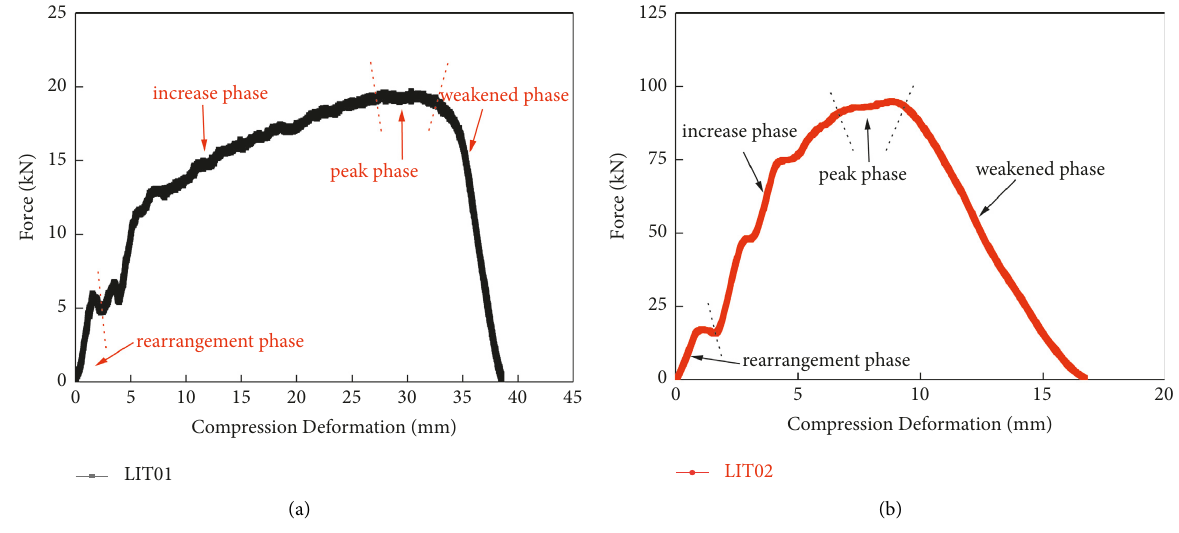
Figure 9: Diagram of impact force and compression deformation of specimen. (a) Group F. (b) Group